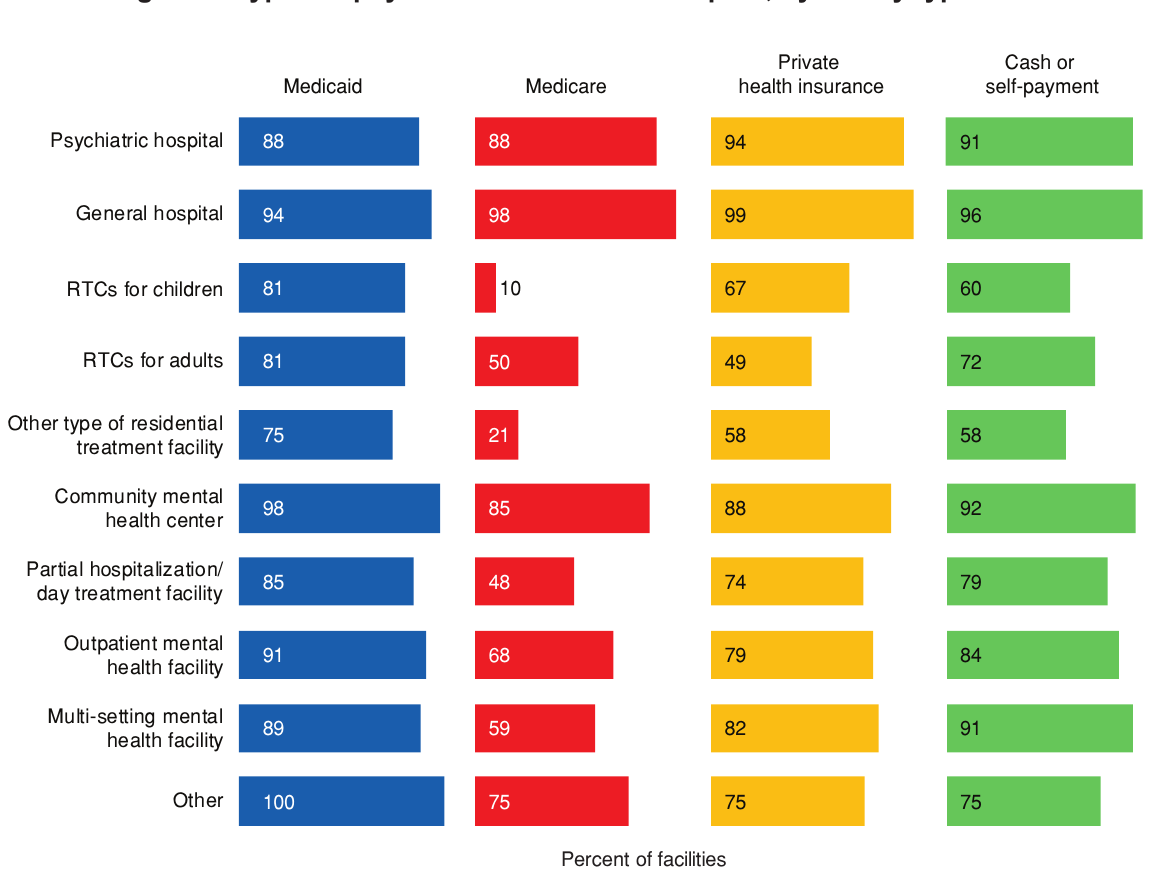
Figure 6. Types of payment or insurance accepted, by facility type: